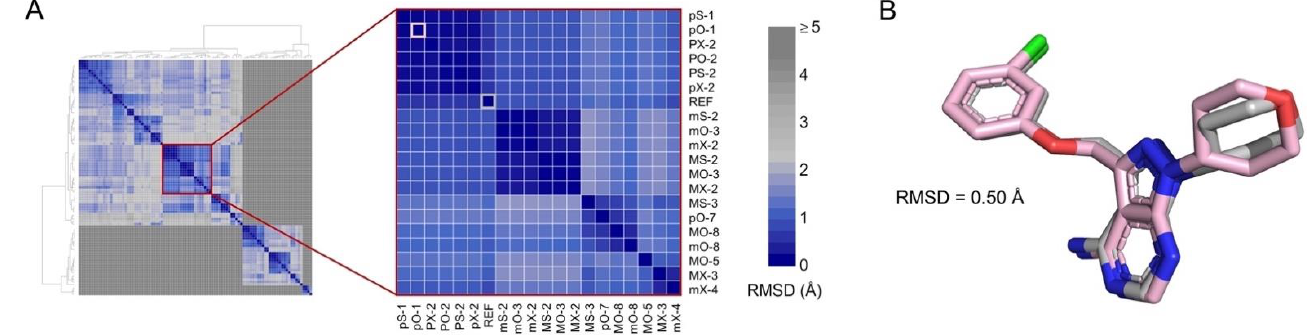
Figure 1. Docking protocol reproduces the active conformer of IN1. ( A ) Hierarchical clustering of 96 poses obtained by molecular docking. Inset shows the largest subcluster. Poses are labeled using letters that indicate the combination of search algorithm/scoring function employed (see “Methods”) and a number indicating the ranked position. The crystal pose of IN1 (REF) and the best scored pose calculated using PLANTS scoring function and Optimizer search algorithm (pO-1) are highlighted in gray and pink, respectively. Color scale shows the RMSD between poses. ( B ) Superimposition of co-crystallized (gray) and pO-1 docked (pink)